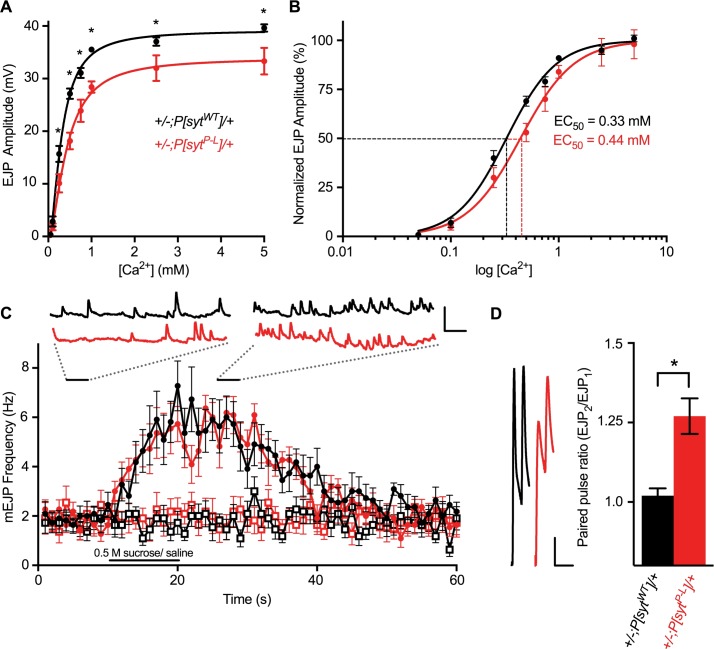
The P[sytP-L] mutation decreases the Ca2+ affinity of release and vesicular release probability, but the readily releasable pool is unchanged.(A) Mean EJP amplitudes from +/-;P[sytWT]/+ (filled black circles) and +/-;P[sytP-L]/+ (filled red circles) larvae at Ca2+ levels ranging from 0.05 mM—5.0 mM. At Ca2+ concentrations above 0.1 mM, statistical differences are seen between the two genotypes (*p < 0.05 for indicated Ca2+ concentrations, see S1 Table for specific n’s and p-values, student t-tests). Lines of best fit were determined using non-linear regression analyses. (B) Graph depicting normalized EJP responses at log Ca2+ concentrations. EC50 values were determined using the line of best fit determined by nonlinear regression analyses. Dotted lines depict the shift in the EC50 value. (C) Application of hypertonic 0.5 M sucrose to +/-;P[sytWT]/+ (n = 11 fibers, filled black circles) and +/-;P[sytP-L]/+ (n = 11 fibers, filled red circles) results in increases in mEJP frequency. Black bar below the traces represents the duration of the 10 second application of 0.5 M sucrose or saline solution. Black bars above the mEJP responses indicate three consecutive seconds of individual traces either before sucrose application (left inset) or during peak sucrose response (right inset). Similar frequencies between +/-;P[sytWT]/+ and +/-;P[sytP-L]/+ are observed both before and during sucrose response (n = 11 fibers for both genotypes, p = 0.28 before sucrose application, p = 0.23 during maximum sucrose response). Application of bath solution does not result in an increase in mEJP frequency in either genotype (open circles) (p = 0.57 for +/-; P[sytWT]/+ and p = 0.83 for +/-;P[sytP-L]/+, student t-test). Scale bar 2mV, 3s. (D) Paired-pulse analysis indicates a decrease in release probability in +/-;P[sytP-L]/+. Left, representative traces of responses stimulated with a 20 ms interpulse interval. Scale bar 5 mV, 40 ms. Right, in P[sytP-L] heterozygotes, the paired pulse ratio is significantly increased (+/-;P[sytWT]/+ = 1.02 ± 0.02, +/-;P[sytP-L]/+ = 1.27 ± 0.06, *p = 0.0008, student t-test). Error bars are SEM.